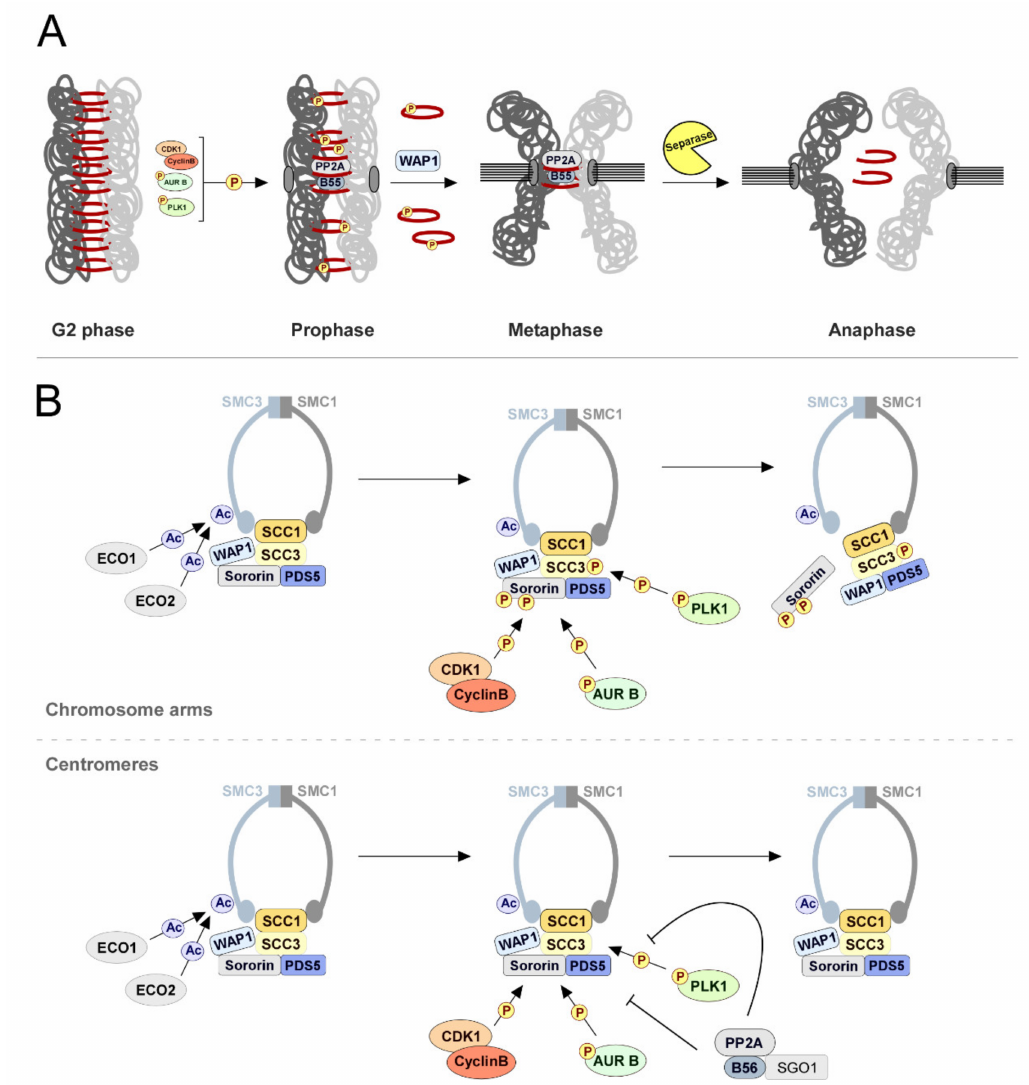
Figure 4. PP2A-B56 maintains centromeric cohesion until anaphase onset. ( A ) Following DNA replication, sister chromatids are held together by cohesin-ring complexes. During prophase, CDK1, PLK1, and Aurora B trigger WAP1-mediated removal of cohesin from chromosome arms. Centromere cohesion is protected from WAP1 by the activity of PP2-B56 bound to SGO1. Centromeric PP2-B56 antagonizes the phosphorylations catalyzed by the mitotic kinases, hence maintaining cohesion at centromeres until kinetochores of all chromosomes are correctly attached to microtubules of opposite spindle poles. At this stage, Separase catalyzes the proteolytic degradation of cohesin complexes, abolishing cohesion and enabling sister chromatid separation in anaphase. ( B ) During G2, cohesin rings are insensitive to WAP1 by Sororin recruited to acetylated SMC3. The presence of Sororin prevents WAPl binding to PDS5. Following mitotic entry, Aurora B- and CDK1-dependent phosphorylation of Sororin causes its dissociation, thus consenting WAP1 binding to PDS5. WAP1-mediated removal of cohesin also requires phosphorylation of SCC3 by PLK1. At centromeres, PP2A-B56 in complex with SGO1 counteracts Aurora B, CDK1, and PLK1 destabilizing phosphorylations and thereby prevents the dissociation of cohesin complexes by